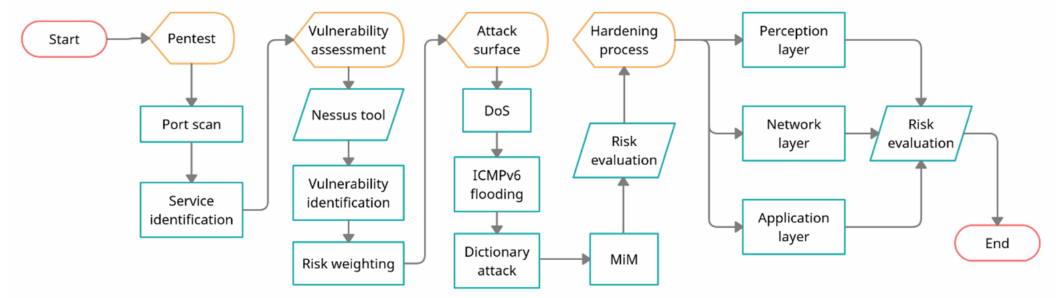
Figure 6. Risk evaluation